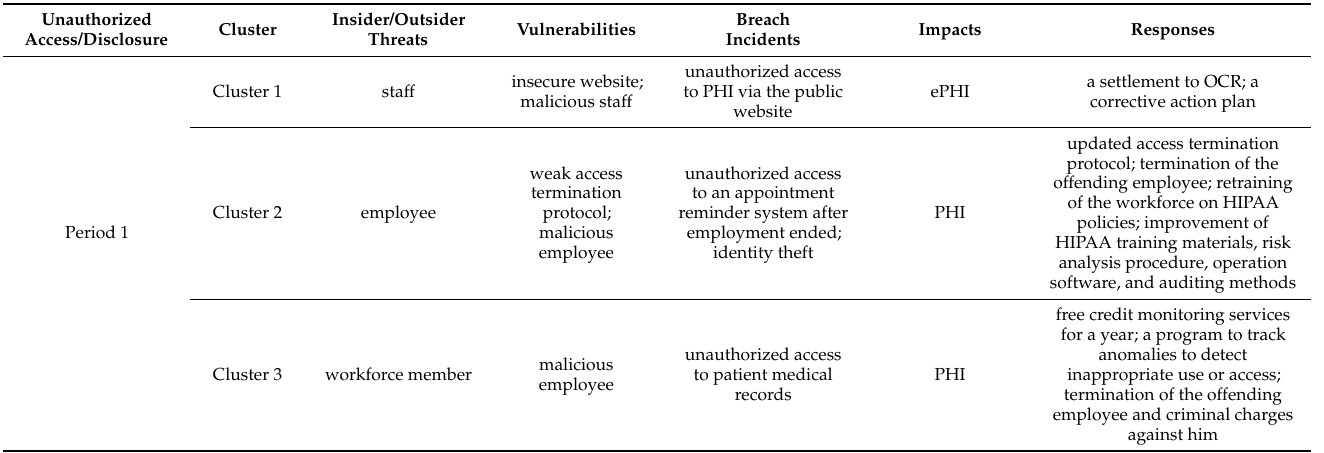
Table 6. Insider/Outsider Threats, Vulnerabilities, Breach Incidents, Impacts, and Responses in Unauthorized